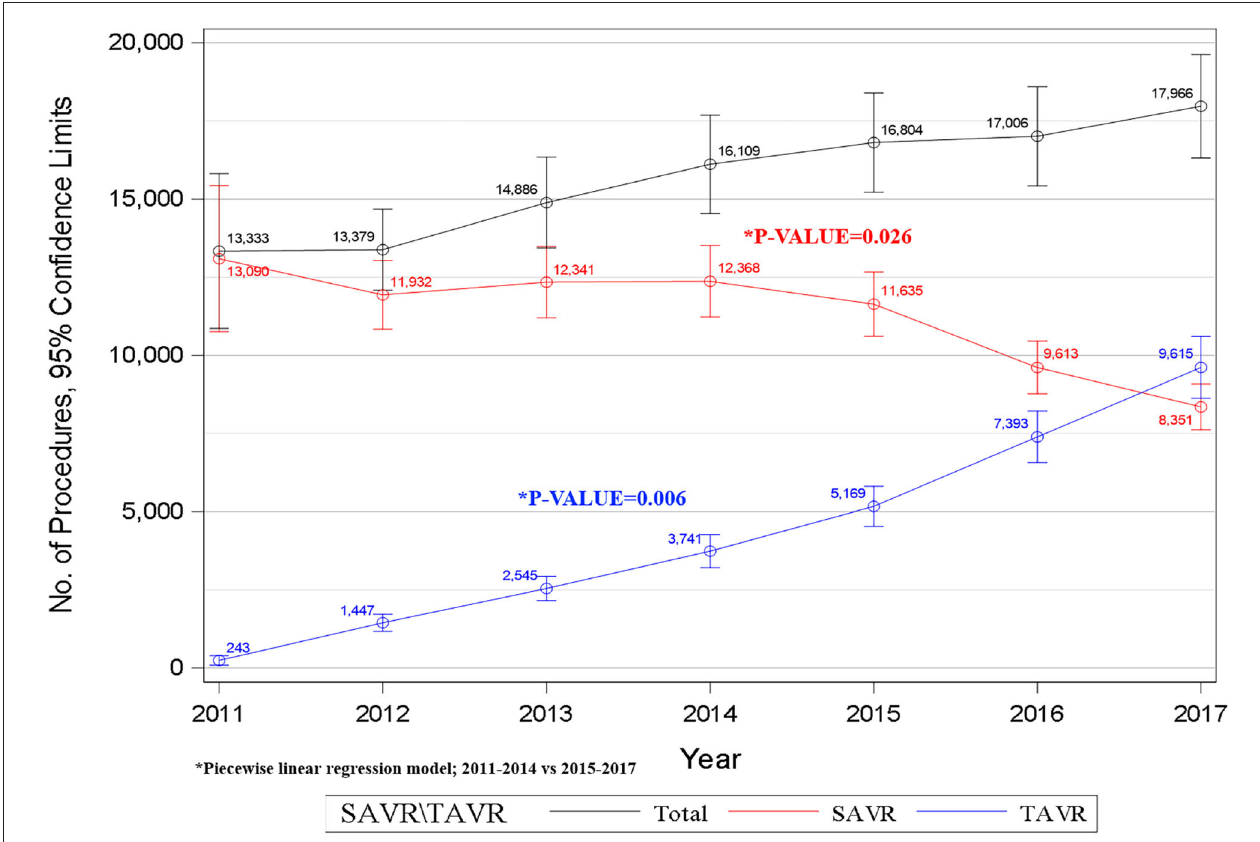
FIGURE 1 | Trends in AVR procedures during the years